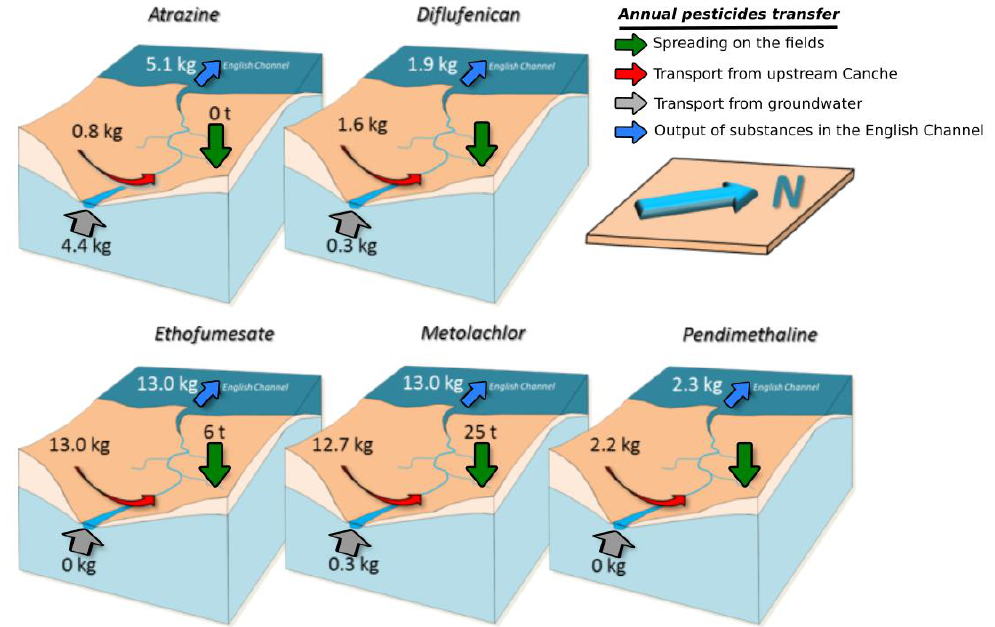
Figure 9. Mass balance of pesticides transfer in the Canche River. Arrows present the annual inputs from (1) spreading on the fields, (2) transport from upstream part of the river, and (3) from groundwater and output of substances in the English Channel (expressed in kg). Values are given for the catchment related to Canche 5 (corresponding to 92% of the total catchment acreage, compare Tables S6–S8).